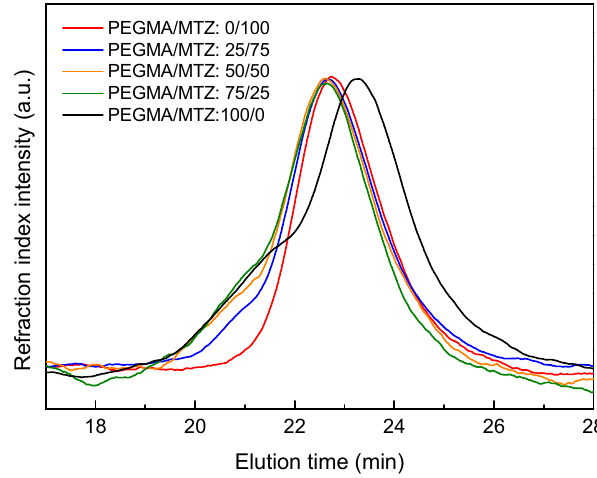
Figure 2. Gel permeation chromatography (GPC) curves of the P(PEGMA– co –MTZ) copolymers synthesized via reversible addition-fragmentation chain transfer (RAFT) polymerization with di ff erent monomer molar ratios PEGMA / MTZ: 100 / 0, 75 / 25, 50 / 50, 25 / 75, and 0 / 100 in the feed.